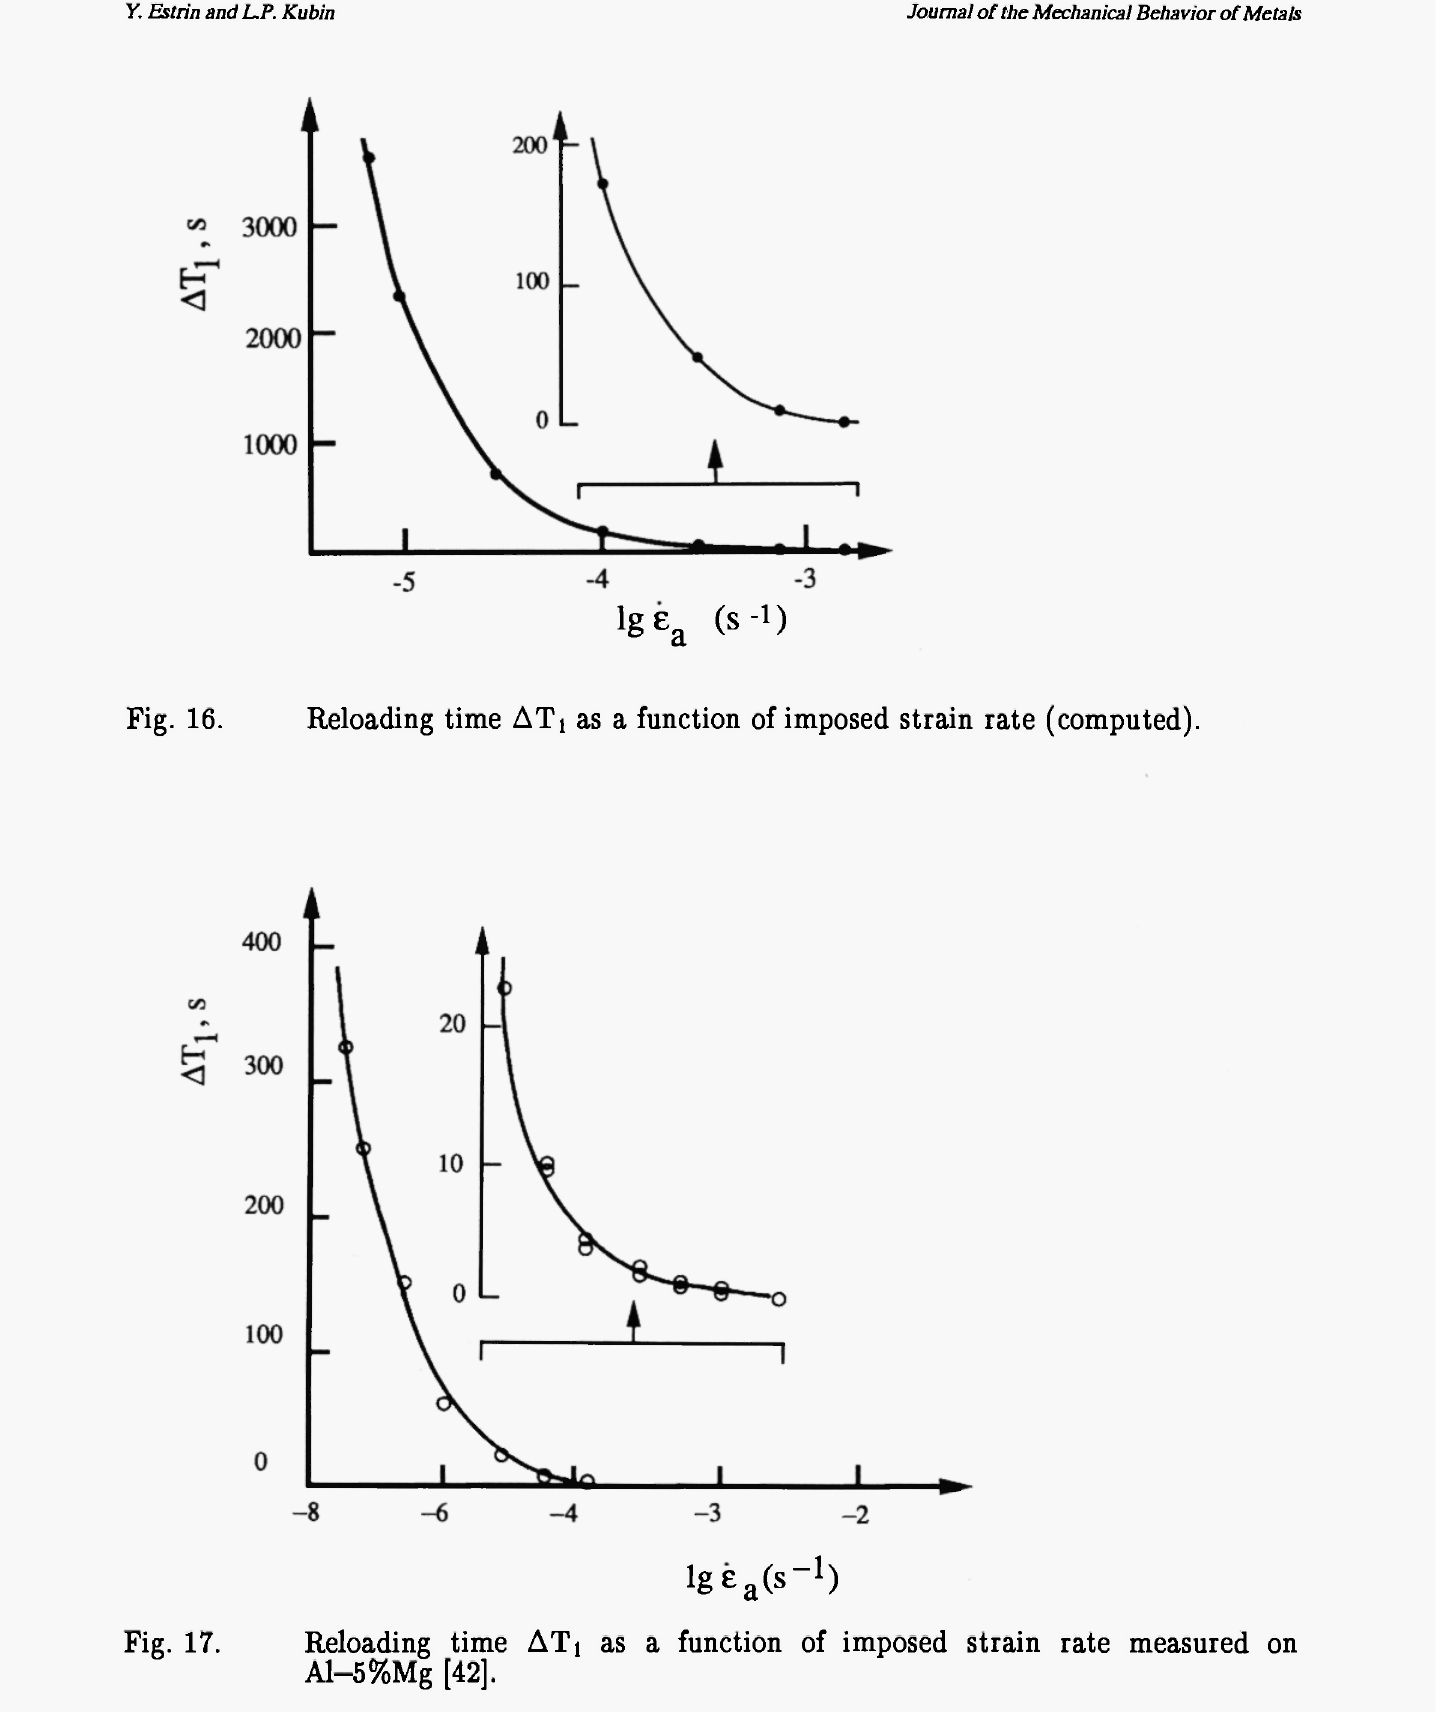
Fig. 17. Reloading time ATj as a function of imposed strain rate measured on Al—5%Mg